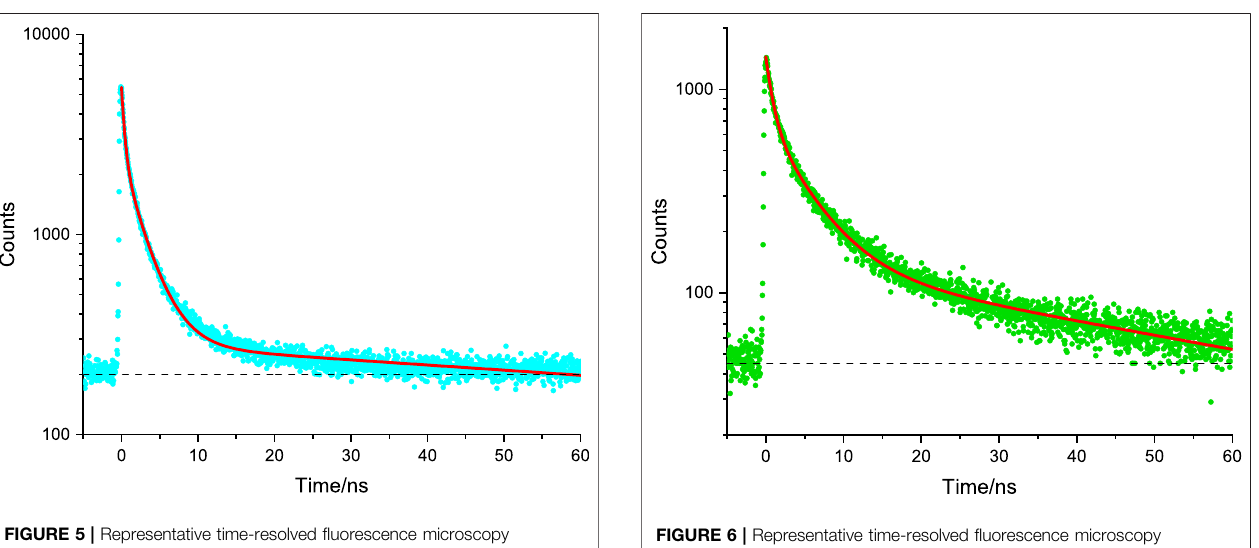
TABLE 1 | Data obtained from time-resolved fl uorescence microscopy and fi tted to a sum of exponentials ( Eq. 1 ). Delivery system